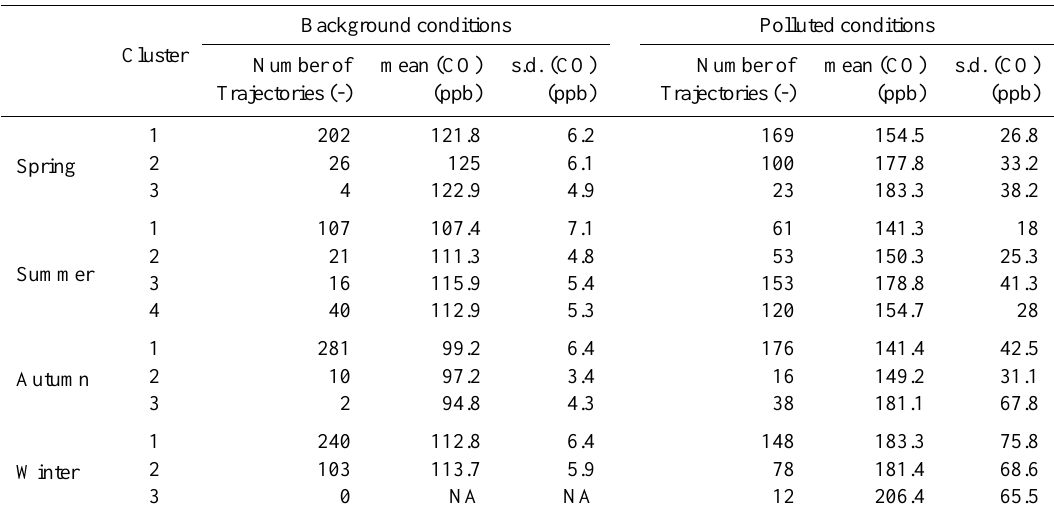
Table 2. Statistical CO results of clusters in different seasons at WLG.